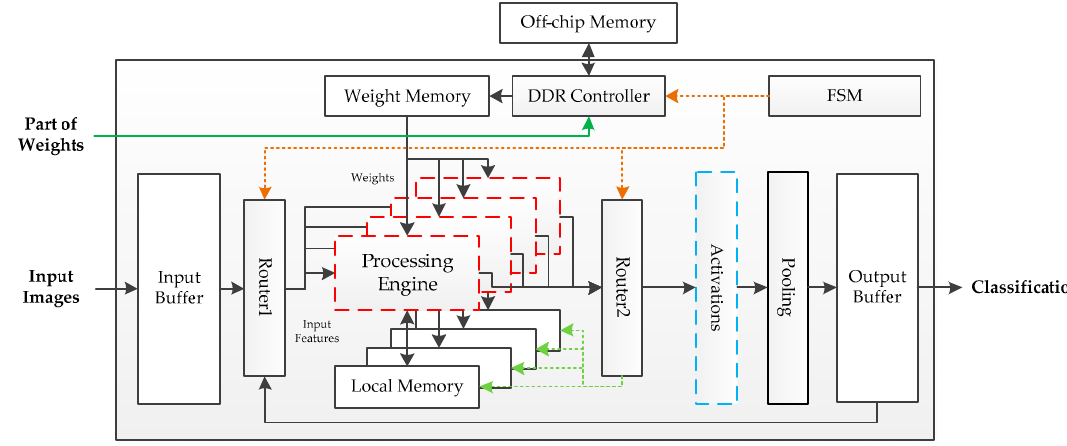
Figure 3. Hardware implementation architecture on the FPGA platform.